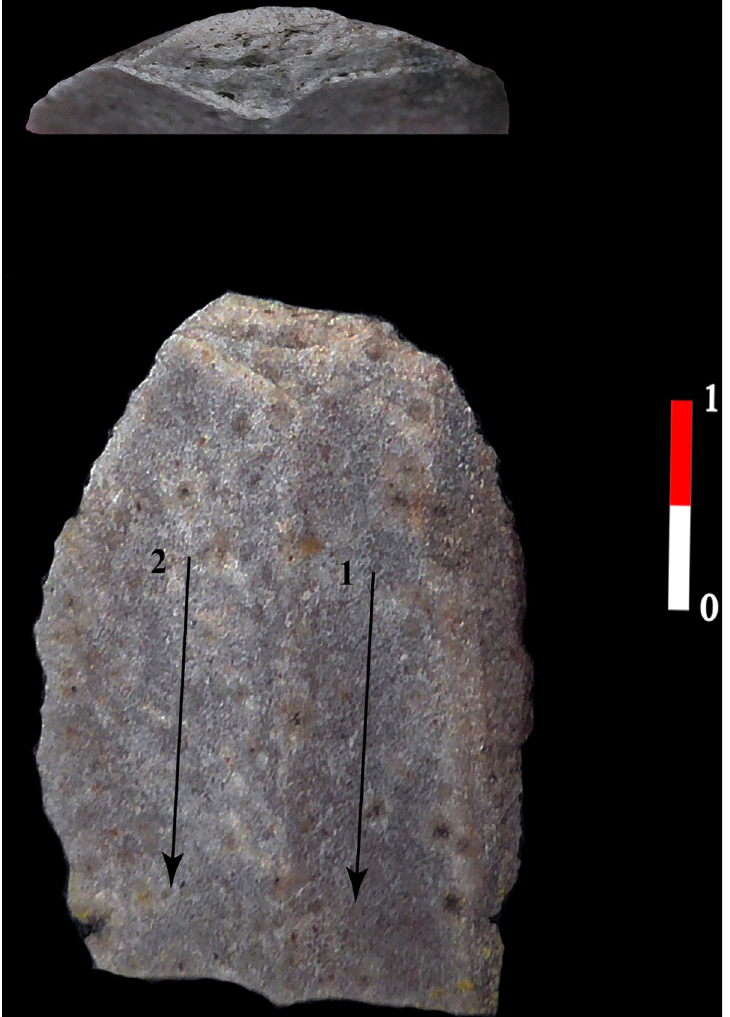
Fig 12. Blade of quartzite in the House 120 of Bucy-le-Long “La He´ronni è re”. Another blade of group 1, the abrasion is also intensive, which shows that the raw material is not linked to this type of preparation, (BLH, 124–821, Soissons, France).